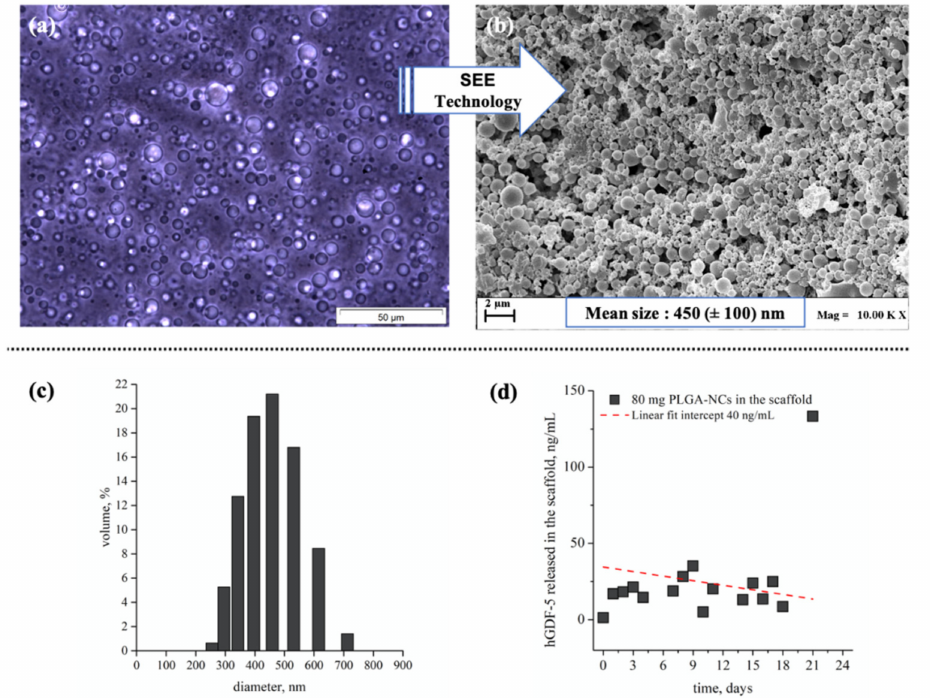
Figure 6. Images of emulsion and derived PLGA-NCs obtained by SEE technology, particle size distribution, and hGDF-5 release profiles within the 3D environment. Optical microscope image of emulsion ( a ) and electronic microscope image ( b ) of carriers obtained after emulsion processing by SEE technology; size distribution data of PLGA carriers expressed as volume percentage ( c ); in vitro hGDF-5 release profile (ng/mL/day) monitored at 37 ◦ C and 100 rpm by ELISA-based assay from 80 mg of carriers, as loaded in each construct ( d ); n =